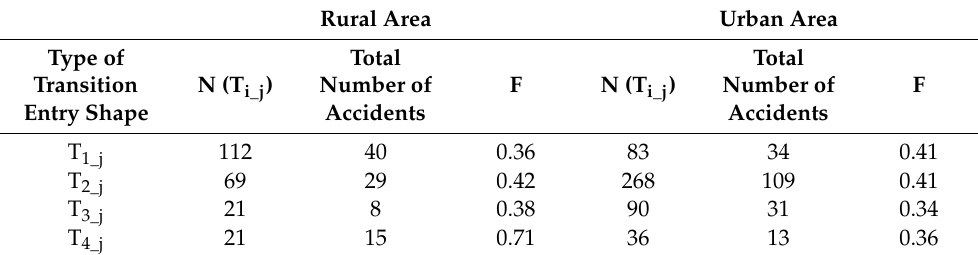
Table 3. Analysis related to the transition entry shape for rural and urban